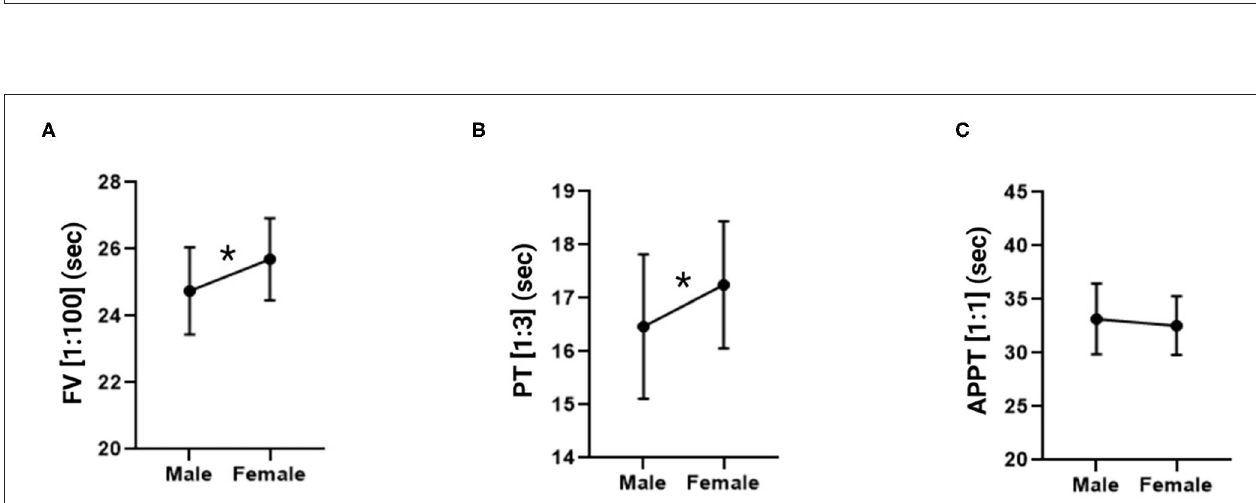
FIGURE 2 | 24-h plasma pool-determinations of factor V in a 1:100 dilution, prothrombin time in a 1:3 dilution and activated partial thromboplastin time in a 1:1 dilution. Hours are represented as Dark 0 (onset of dark) to Dark 11 and Ligth 0 (onset of light) to Ligth 11. The graphs were divided according to the statistical groupings analyzed. (A) Representation of hourly measurements. (B) Combined representation of measurements every 3h. (C) Combined representation of measurements every 6h. Data is expressed as mean ± standard deviation.